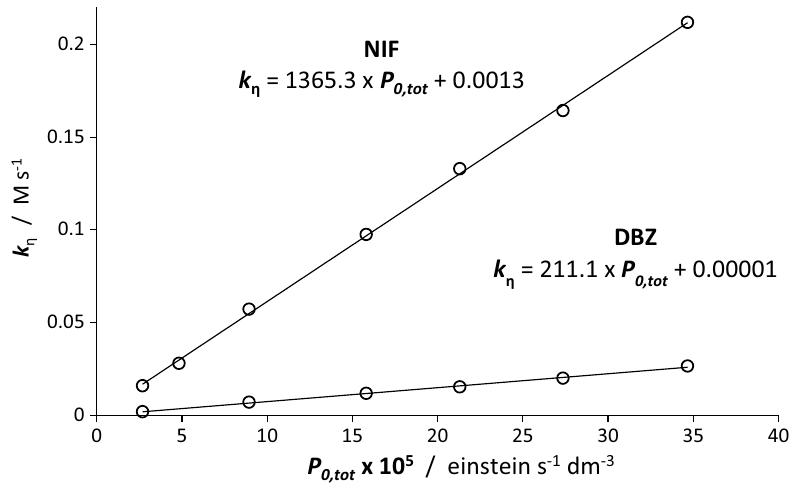
Figure 8. Linear correlations between experimental values of the overall rate-constant ( k η ) and the total radiant (cid:31) power ( P (cid:31) 0, tot ) of Lamp #4 for DBZ and NIF in ethanolic solutions (2.3 and 2.69 × 10